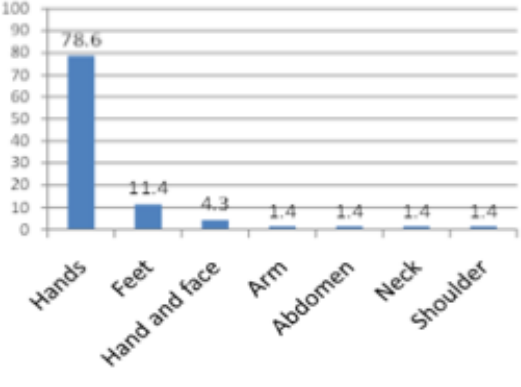
prevalenceFigure 4: Bar diagram showing distribution of the lesions